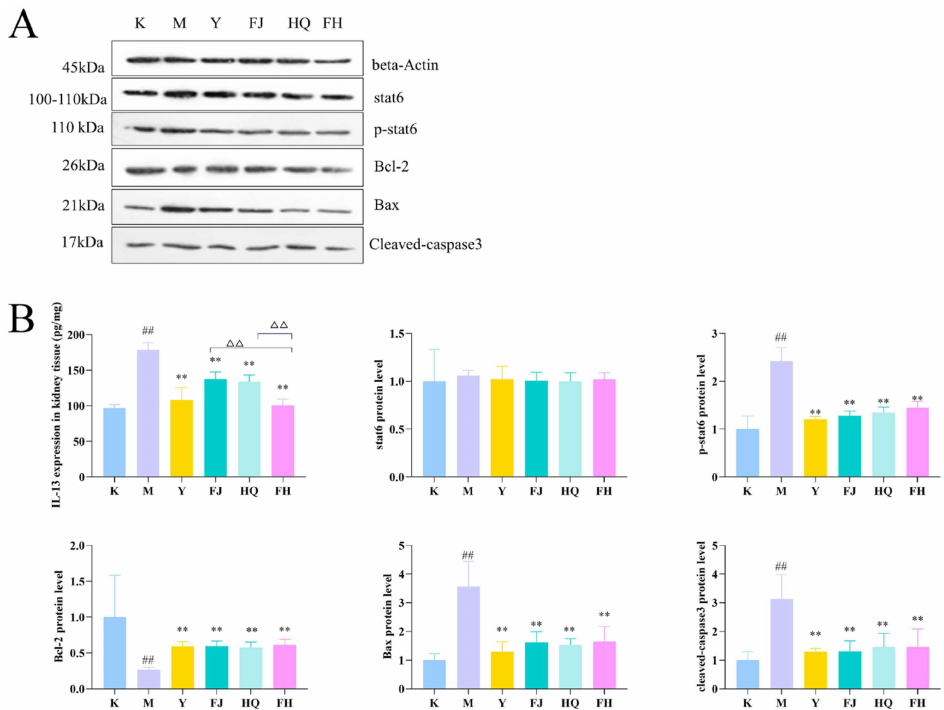
Figure 4. Western blot analysis of the effects of Y, FJ, HQ, and FH on the expression of p-STAT6, Bcl-2, Bax, and cleaved-caspase3 ( A ). Relative quantitative data for p-STAT6, Bcl-2, Bax, and cleaved- caspase3 ( n = 3), and levels of IL-13 in kidney tissue ( n = 6) ( B ). Compared with the K group, ## p < 0.01; compared with the M group, ** p < 0.01; compared with the FH group, (cid:52)(cid:52) p <